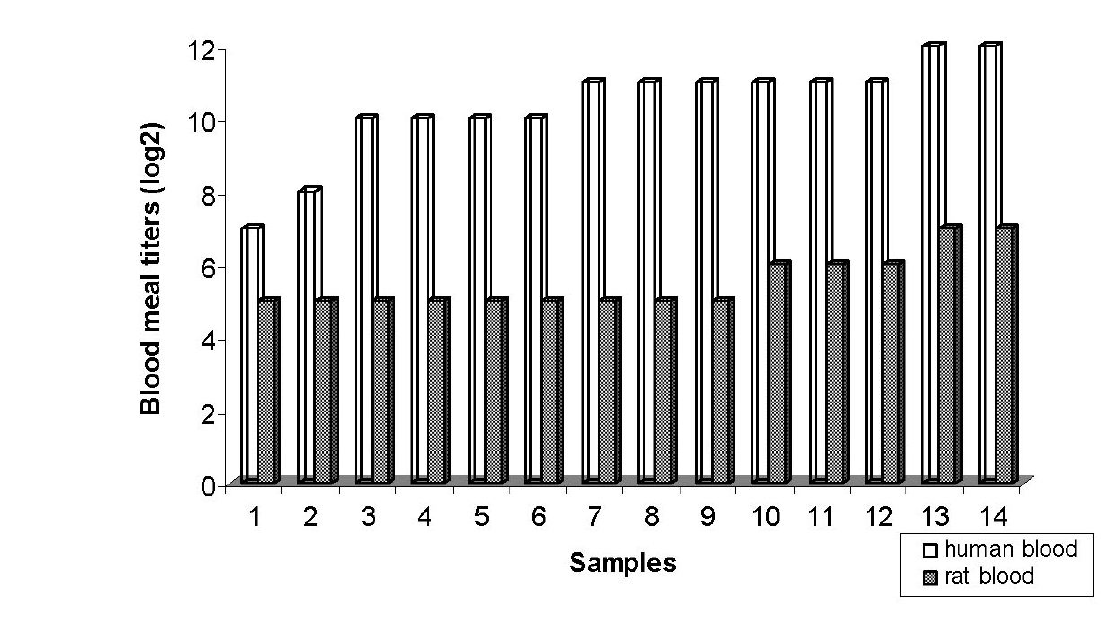
Figure 3. Titers distribution for identified human and rat blood meals of Culex quinquefasciatus